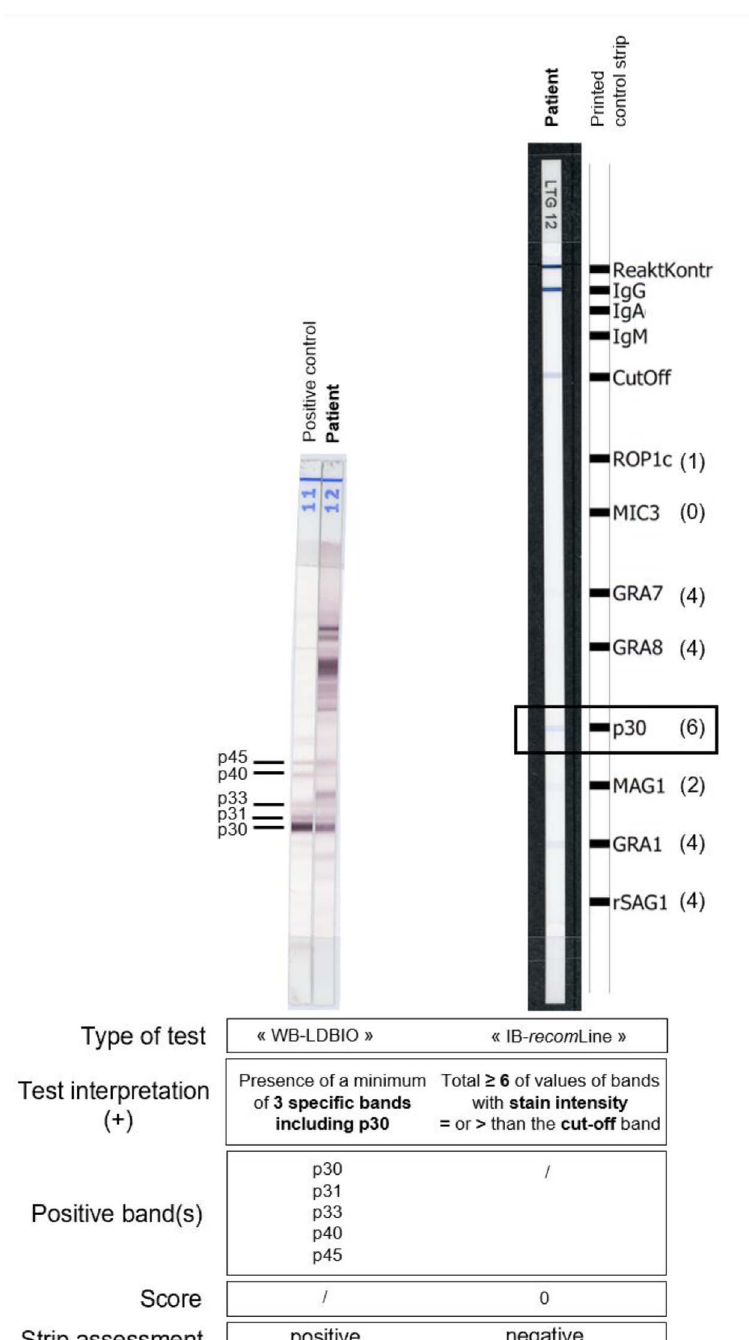
Figure 2. Example of a false-negative result with IB- recom Line compared to WB-LDBIO. The number of points reported by positive bands with IB- recom Line is speci fi ed in parentheses behind each antigen